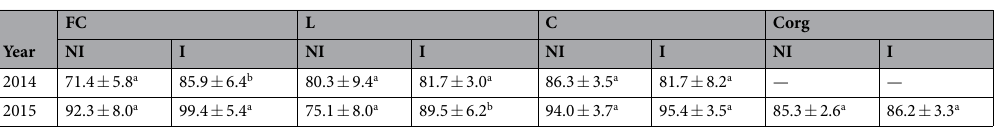
Table 4. Percentage of sown seeds making mature plants at harvest. Sub-plots received no nitrogen fertilization in the four fields (FC, L, C, Corg) during the two years of the study. Mature plants at harvest were counted and then expressed as mean percentages (%) of initially sown seeds. Letters a/b below numbers refer to significance classes at p < 0.05 after two-by-two comparisons between A . lipoferum CRT1-inoculated and